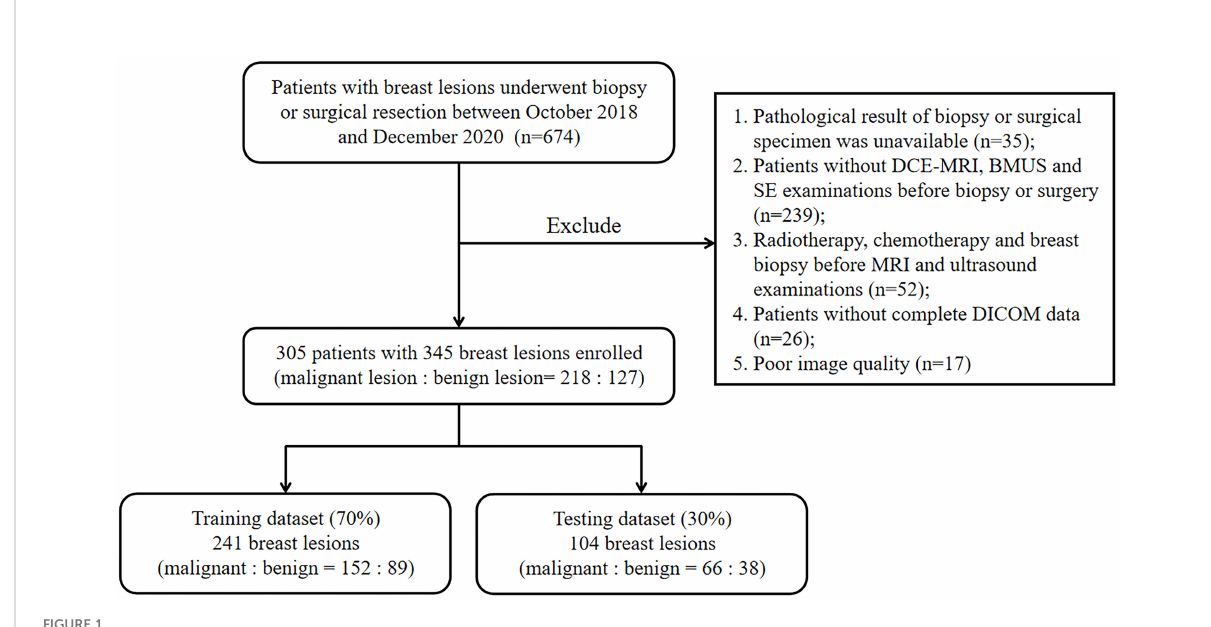
FIGURE 1 The fl owchart of patient selection for this retrospective